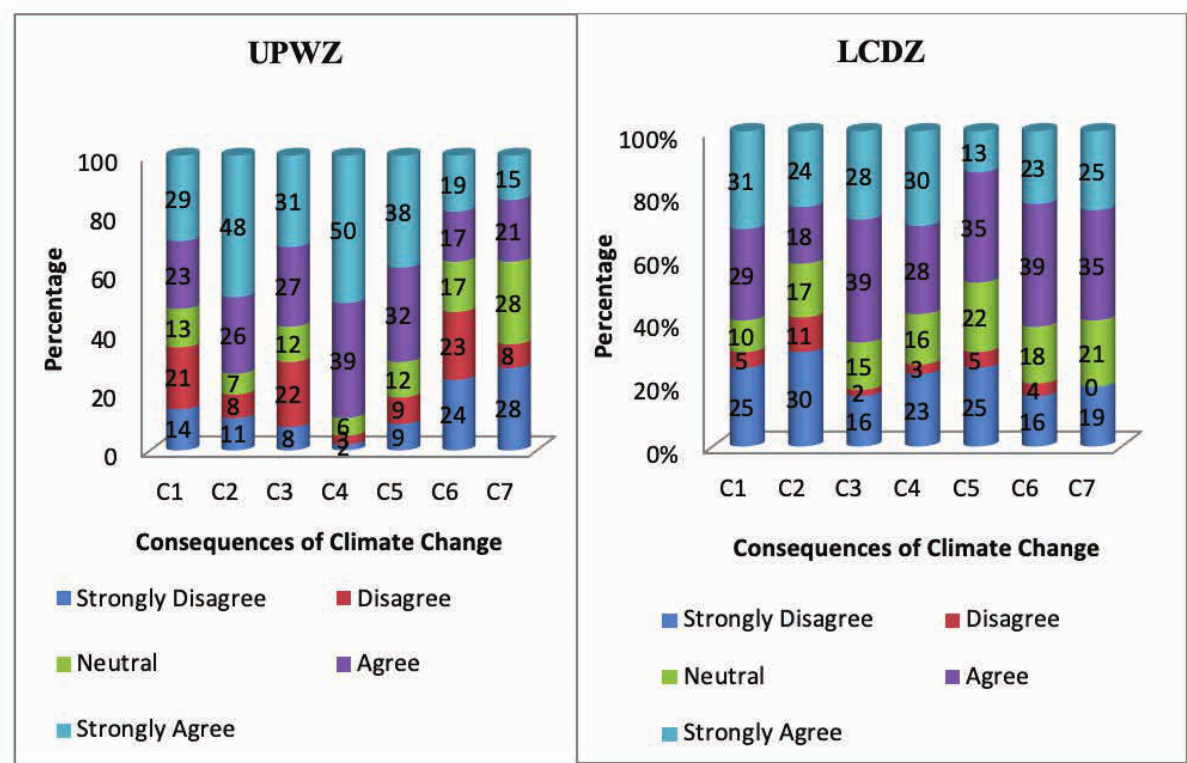
Figure 2: Consequences of Climate Change on Agriculture perceived by the respondents in UPWZ and